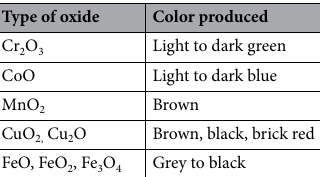
Table 3. Examples of colored glassy layers produced on the surface of zeolite mortar by laser irradiation 32 .